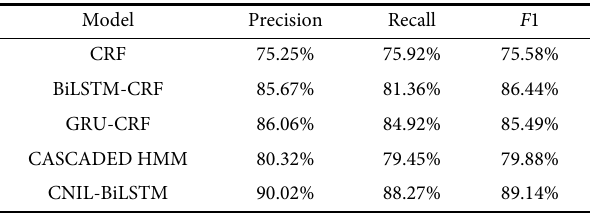
Table 3 Experimental results